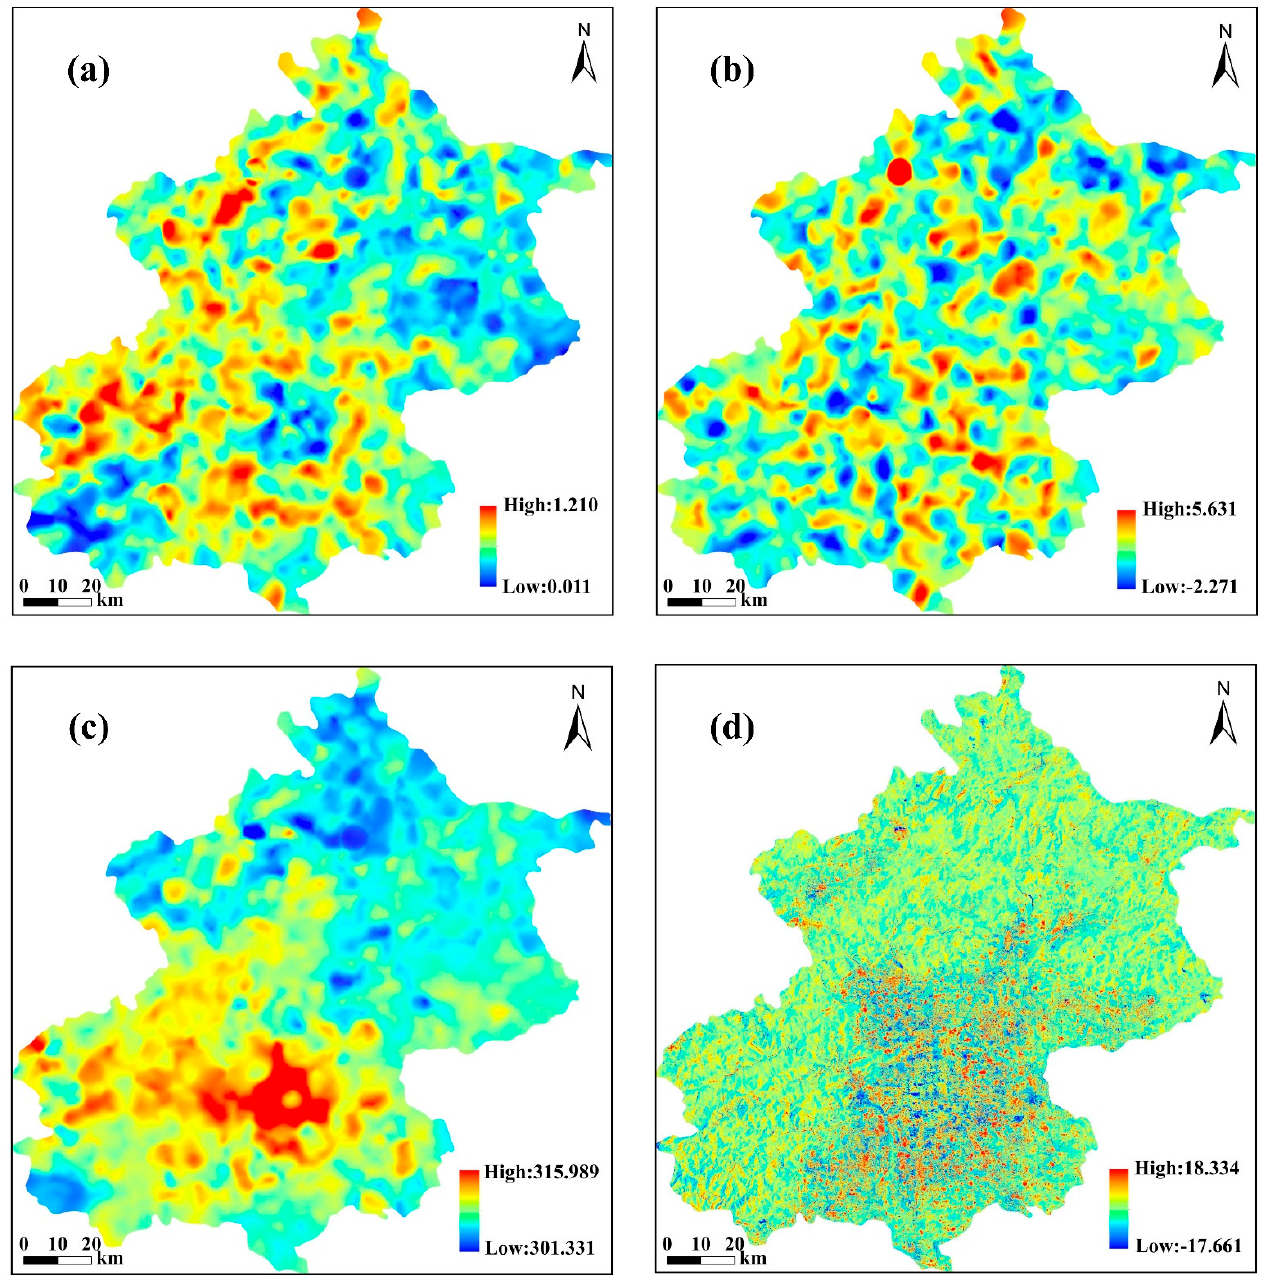
Figure 5. Spatial distribution of the 30 m multi-factor geographically weighted machine learning (MFGWML) model parameters: ( a ) slope of principal component 1 (PC1), ( b ) slope of PC2, ( c ) intercept ( K ), and ( d ) residual.